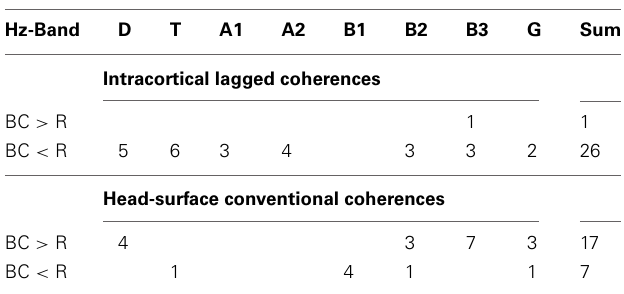
Table 3 | Number of coherences higher ( > ) or lower ( < ) during breath counting (BC) than resting (R) at p < 0 . 01 in the eight EEG frequency bands.